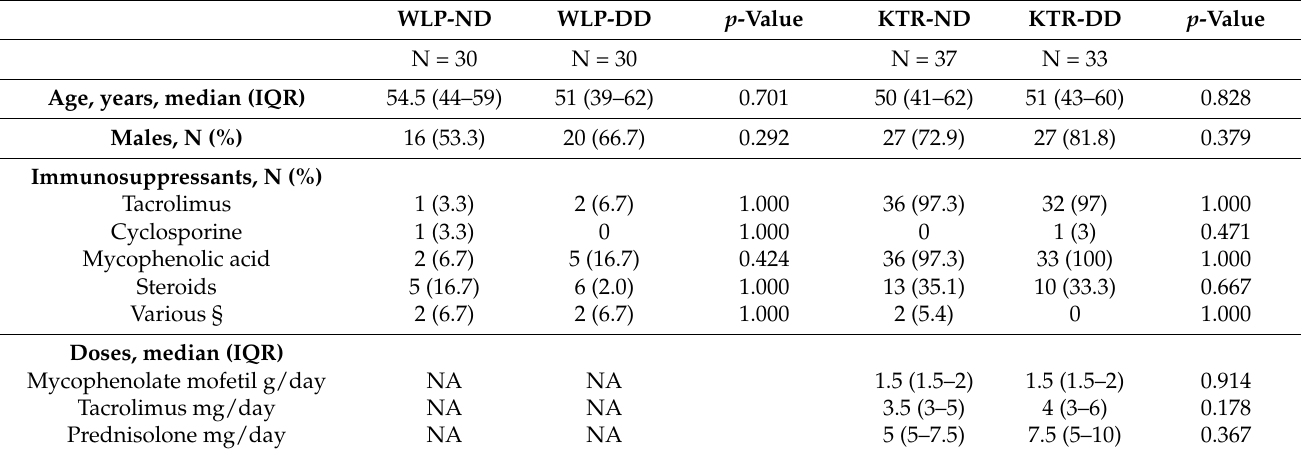
Figure 1. Flow diagram of patients through the study. Abbreviations: KTR, kidney transplant recipient; WLP, patients on the kidney transplant waiting list; ND, normal dose; DD, double dose; PCV13, 13-valent pneumococcal conjugate vaccine; PPV23, 23-valent pneumococcal polysaccharide; KTX, kidney transplantation. Table 1. Baseline demographics, immunosuppressive treatments, and kidney transplants performed during the trial.